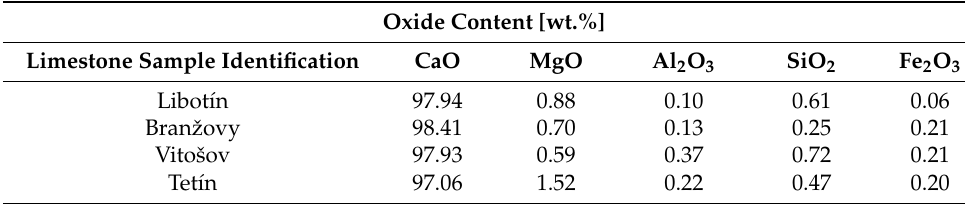
Table 1. Selected oxide content in limestone samples via XRF analysis. Oxide Content [wt.%]